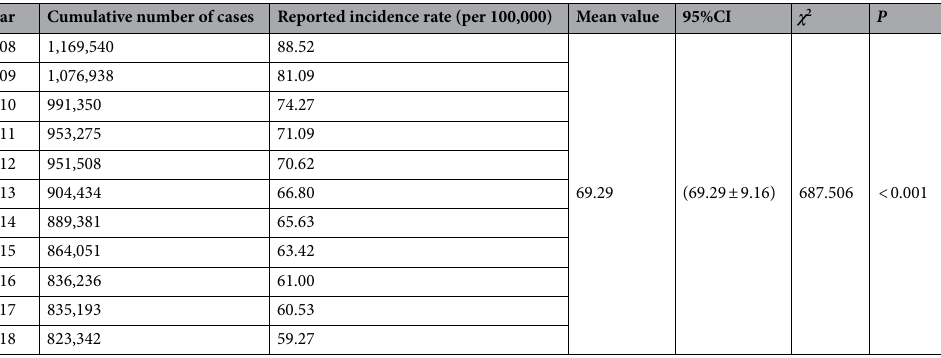
Table 1. Reported incidence of pulmonary tuberculosis in China from 2008 to 2018.